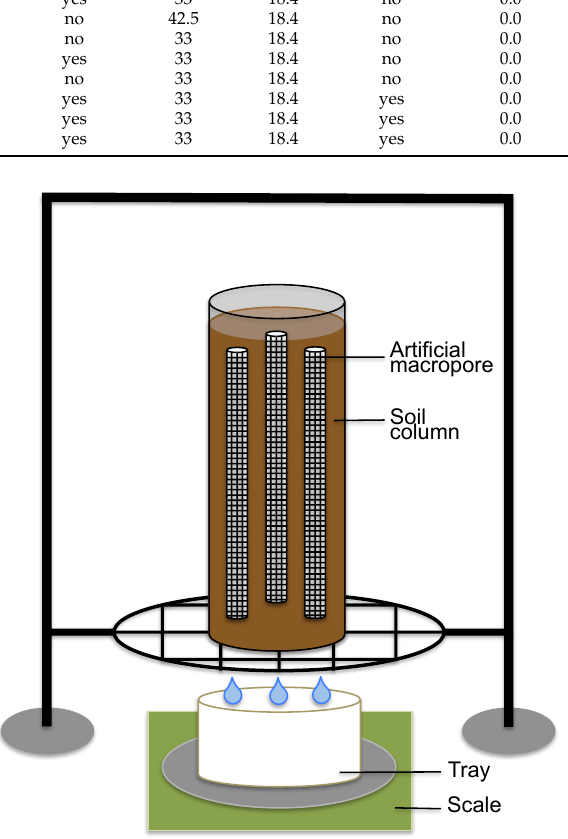
Figure 1. Set-up of soil column